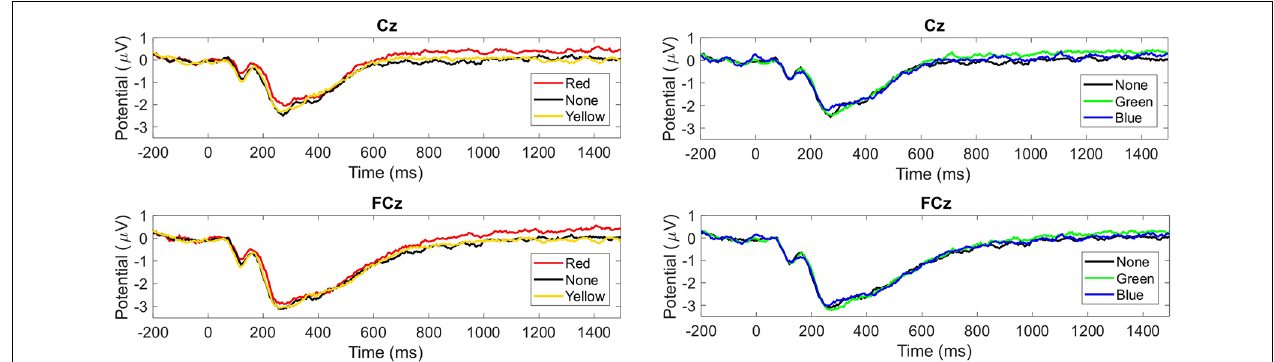
FIGURE 3 | Group mean event-related potentials (ERPs) evoked by tint condition. Upper graphs from Cz and lower graphs from FCz. Left: red-, none- and yellow-tinted lens. Right: none-, green- and blue-tinted lens. Time in milliseconds from picture onset is plotted.